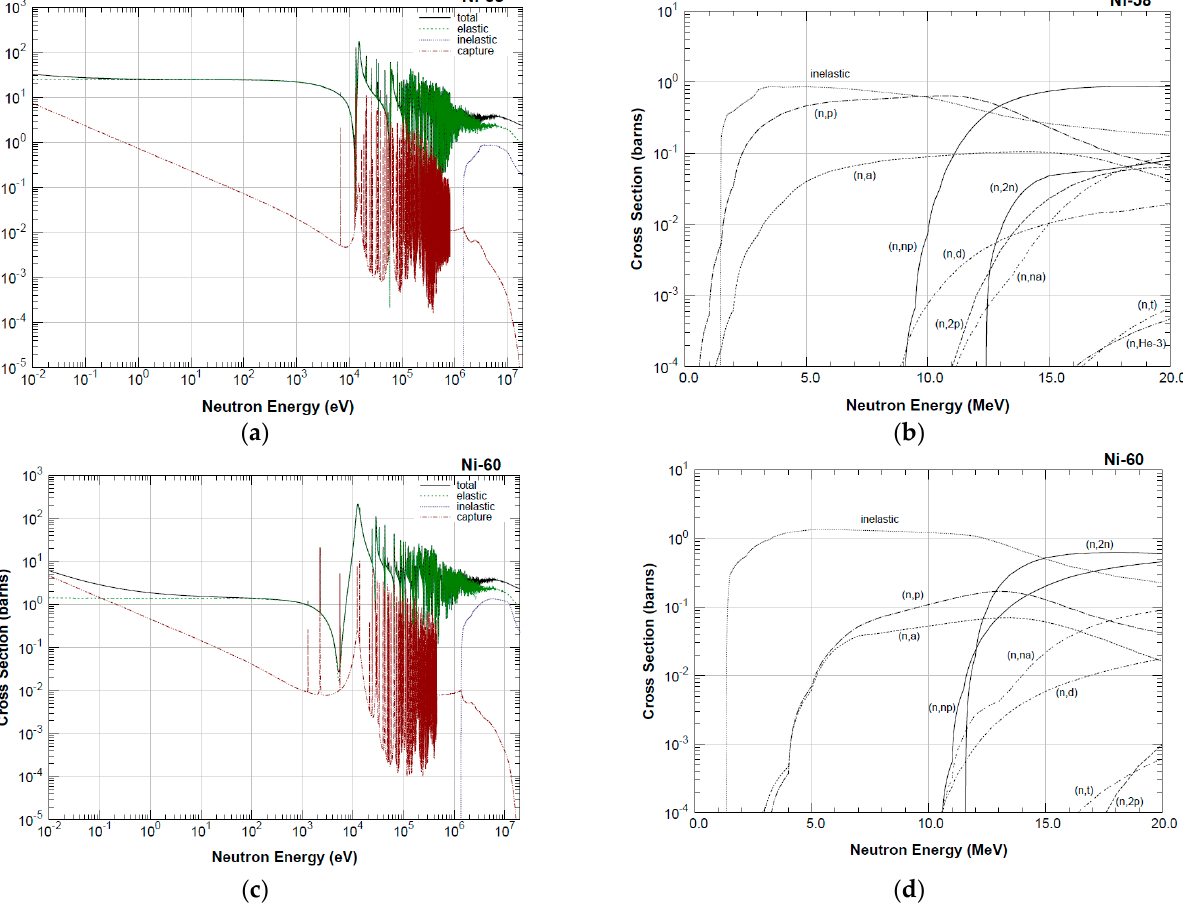
Figure 6. Energy dependences: ( a , c )—effective nuclear cross-section of neutron interaction reactions with nuclei 58 Ni and 60 Ni; ( b , d )—cross-sections of neutron capture reactions for 58 Ni and 60 Ni.